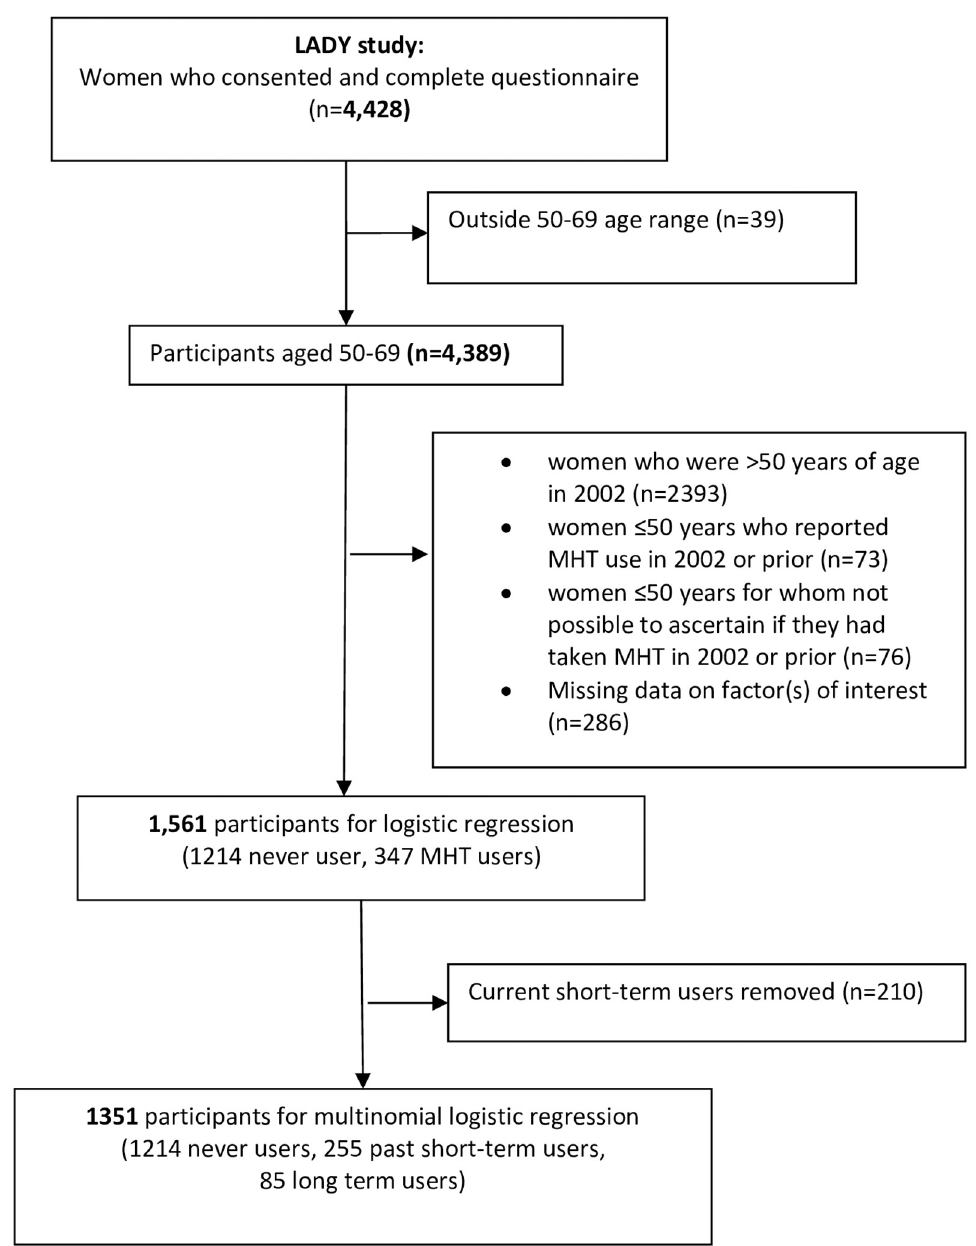
Fig 1. Flow diagram showing participation in the current